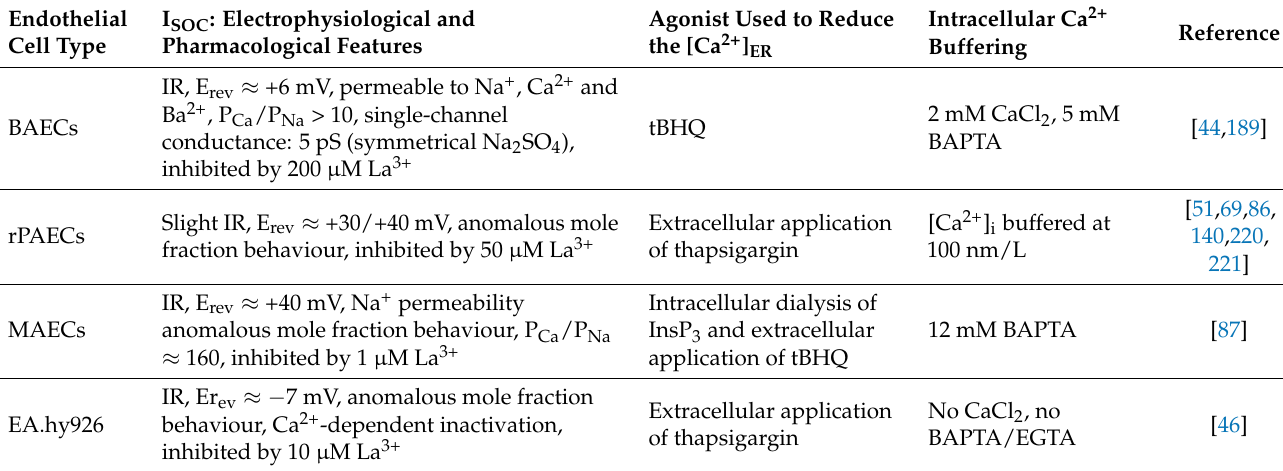
Table 7. Electrophysiological features of the endothelial I CRAC -like